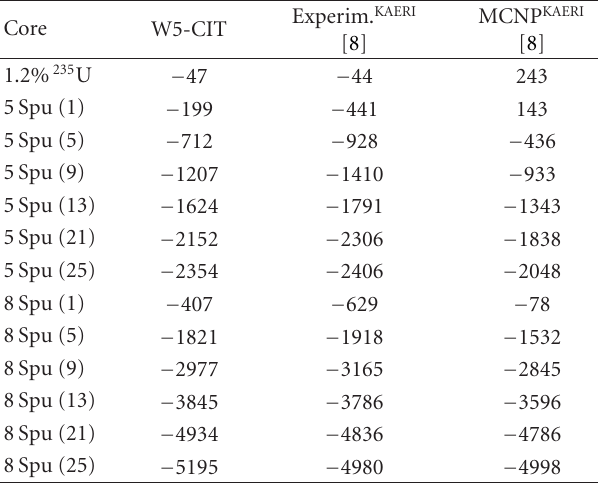
Table 2: Validation results on the void